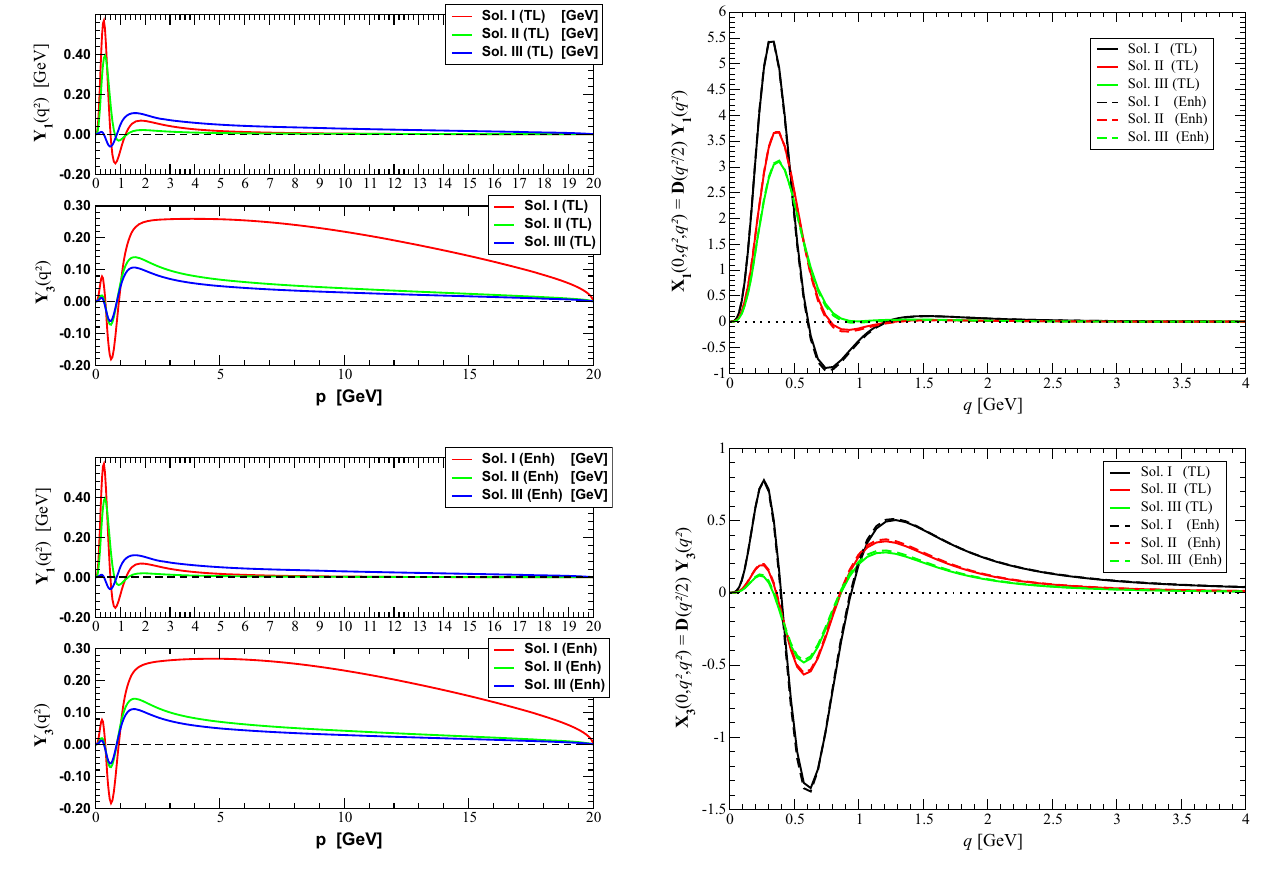
Fig. 17 The quark-ghost kernel form factors X 1 (top) and X 3 (bottom) as defined in Eqs. (60) and (61) for the soft quark limit defined by a vanishing quark